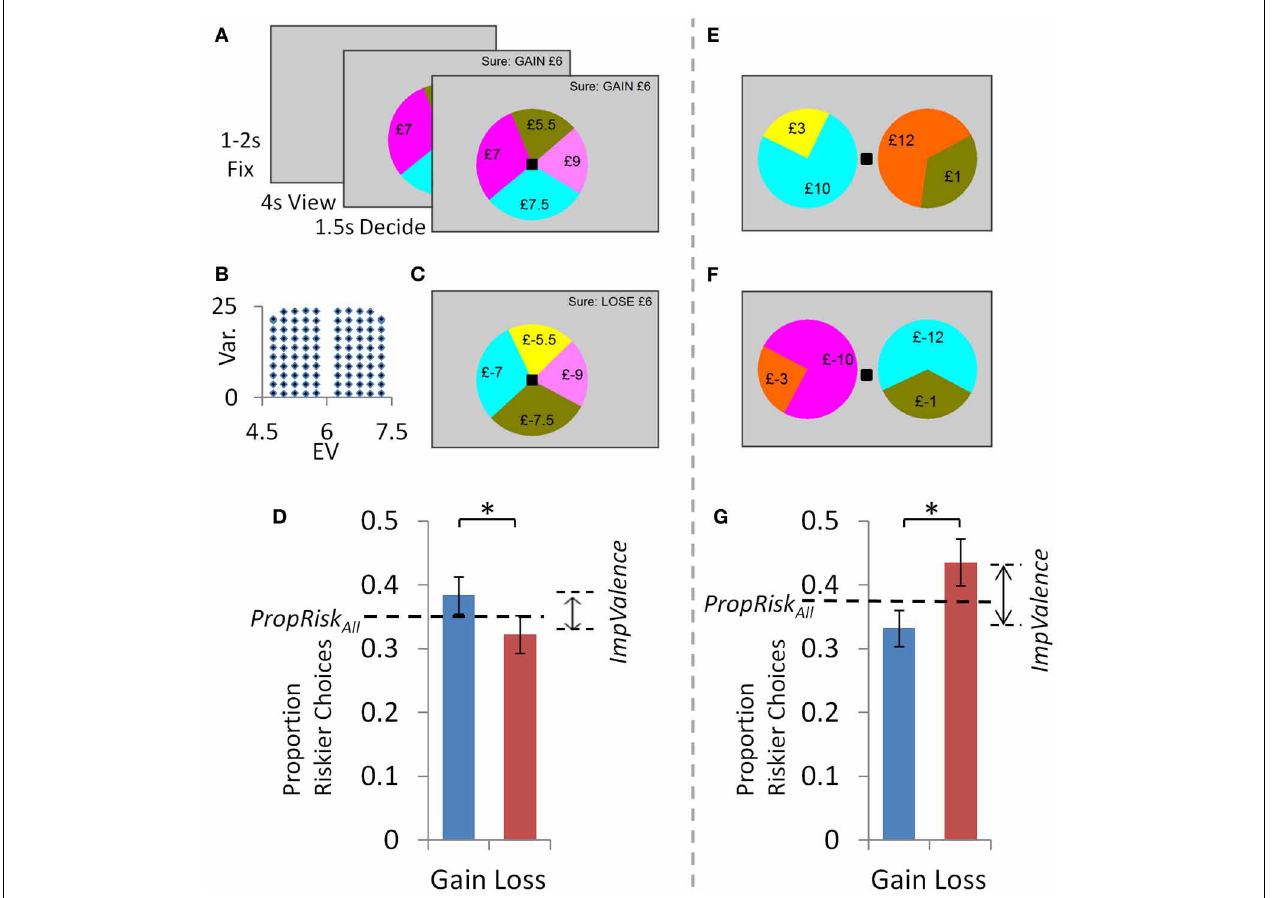
FIGURE 1 | Experiment 1: dissociating valence and risk related influences using task design. In the “accept/reject” task: (A) In each “gain trial” individuals either accepted a lottery (four possible outcomes, all ≥ 0) or rejected and so received £6 for certain. (B) A set of 100 “gain trials” parametrically and orthogonally manipulated lottery risk and EV. Half the lotteries had an EV above the sure amount and half below, so the proportion of riskier choices indexed risk preference (PropRisk; risk-averse < 0.5; risk-neutral = 0.5; risk-seeking > 0.5). (C) Multiplying all “gain trial” amounts by − 1 gave 100 “loss trials”. All 200 trials were presented in random